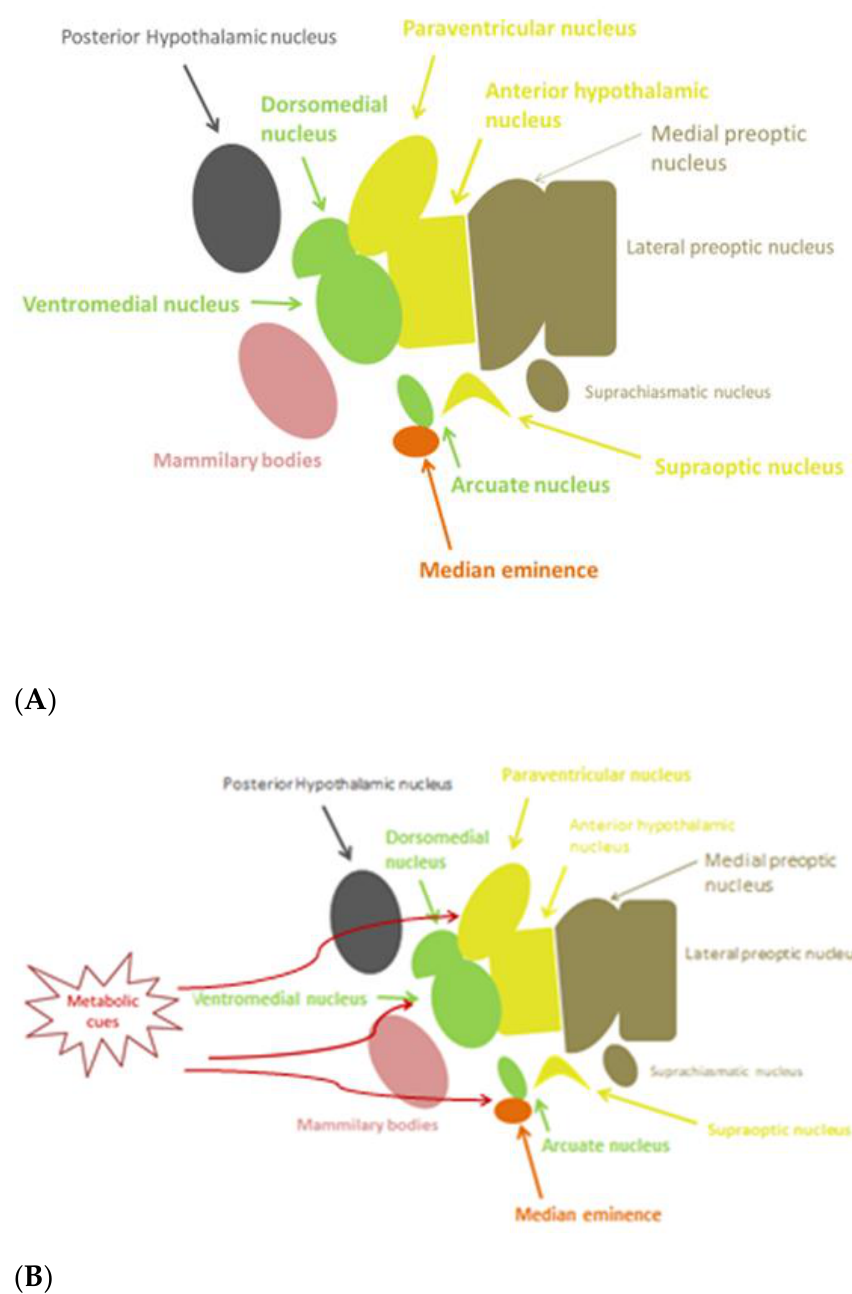
Figure 1. ( A ) Anatomy of hypothalamic nuclei; ( B ) Areas affected by metabolic cues in the hypo- thalamus.